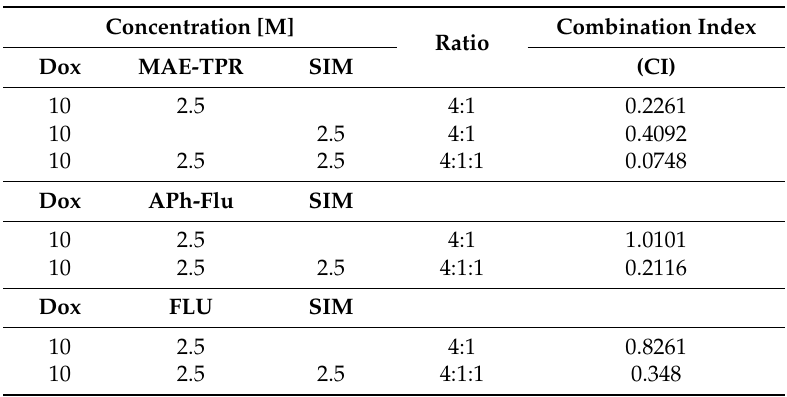
Table 1. Combination of phenothiazine derivatives and simvastatin (SIM) with doxorubicin (Dox) against LoVo/Dx cell growth. Ratio